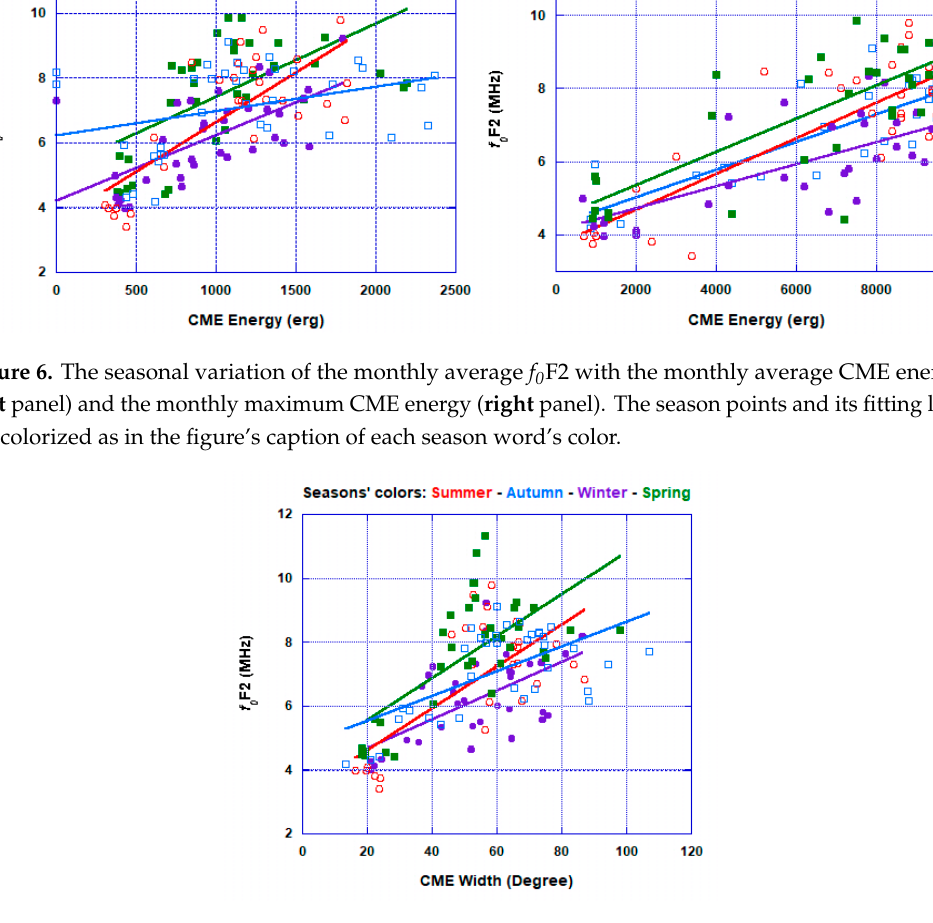
Figure 8. The seasonal variation of the monthly average f 0 F2 as a response to the monthly average CME initial speed variation. The season points and its fitting line are colorized as in the figure’s caption of each season word’s color.